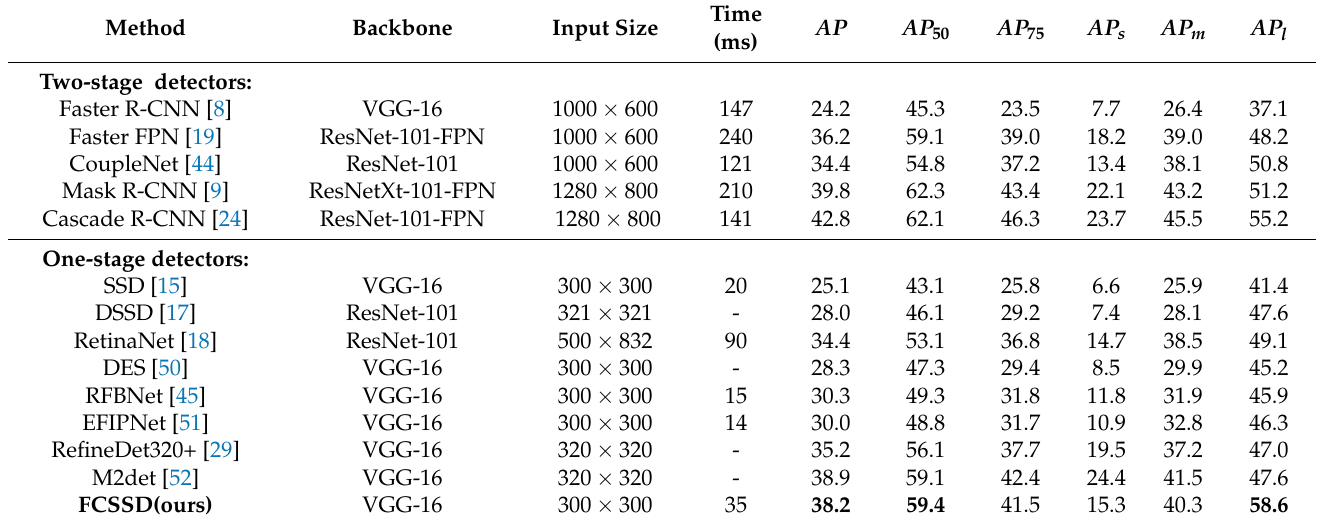
Table 3. The results of the mainstream one-stage and two-stage detectors on the MS COCO